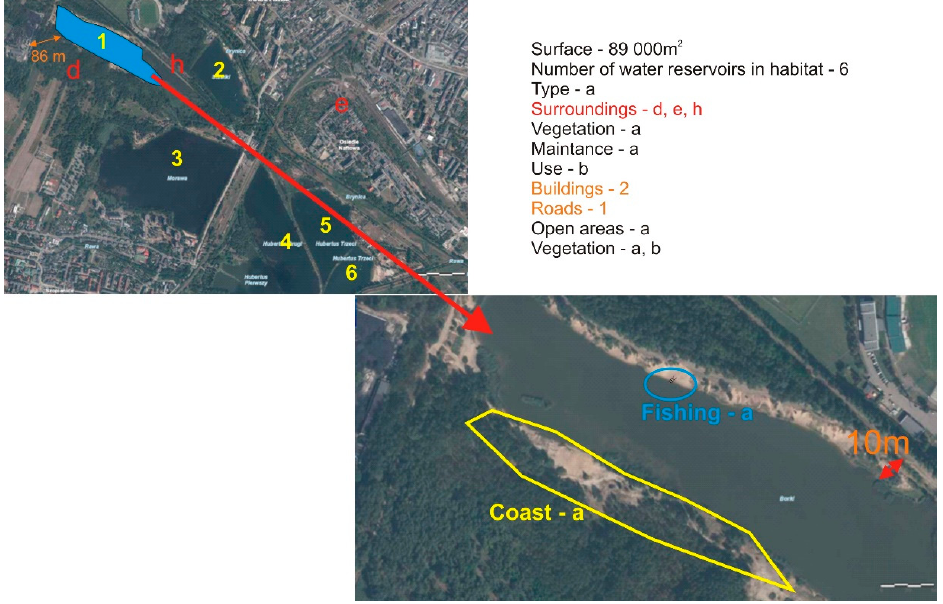
Figure 4. Assessment of sample water reservoirs, (adapted from [39]).